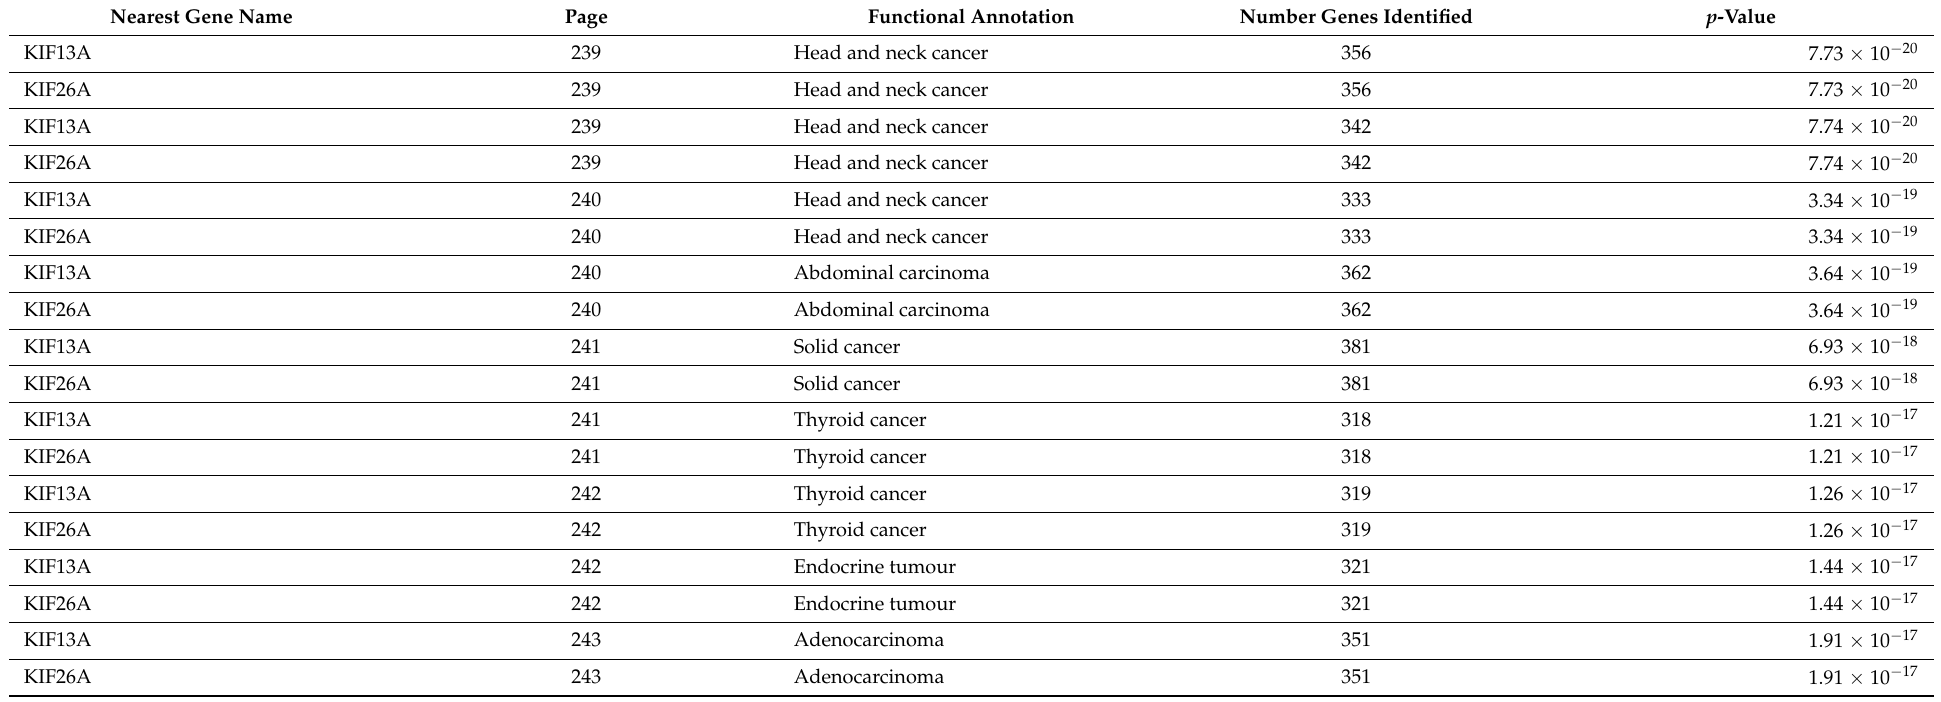
Table 10. Functional Annotations on Most Significant EWAS Hits on Kinesins from Schrott Datasets